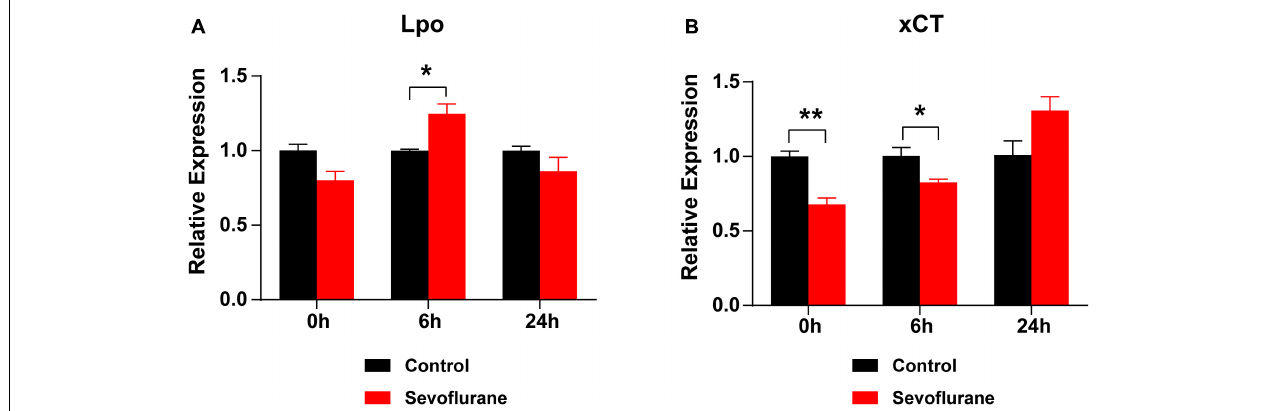
FIGURE 8 | Oxidative stress is elevated after sevoflurane exposure. (A) mRNA expression of Lpo is upregulated at 6 h, rather than at 0 or 24 h, in the sevoflurane group compared to that in the control group. (B) The mRNA expression of xCT is downregulated at 0 and 6 h in the sevoflurane group. No difference is observed between the control and sevoflurane groups at 24 h ( n = 6 per group). * P < 0.05, ** P < 0.01, unpaired Student’s t